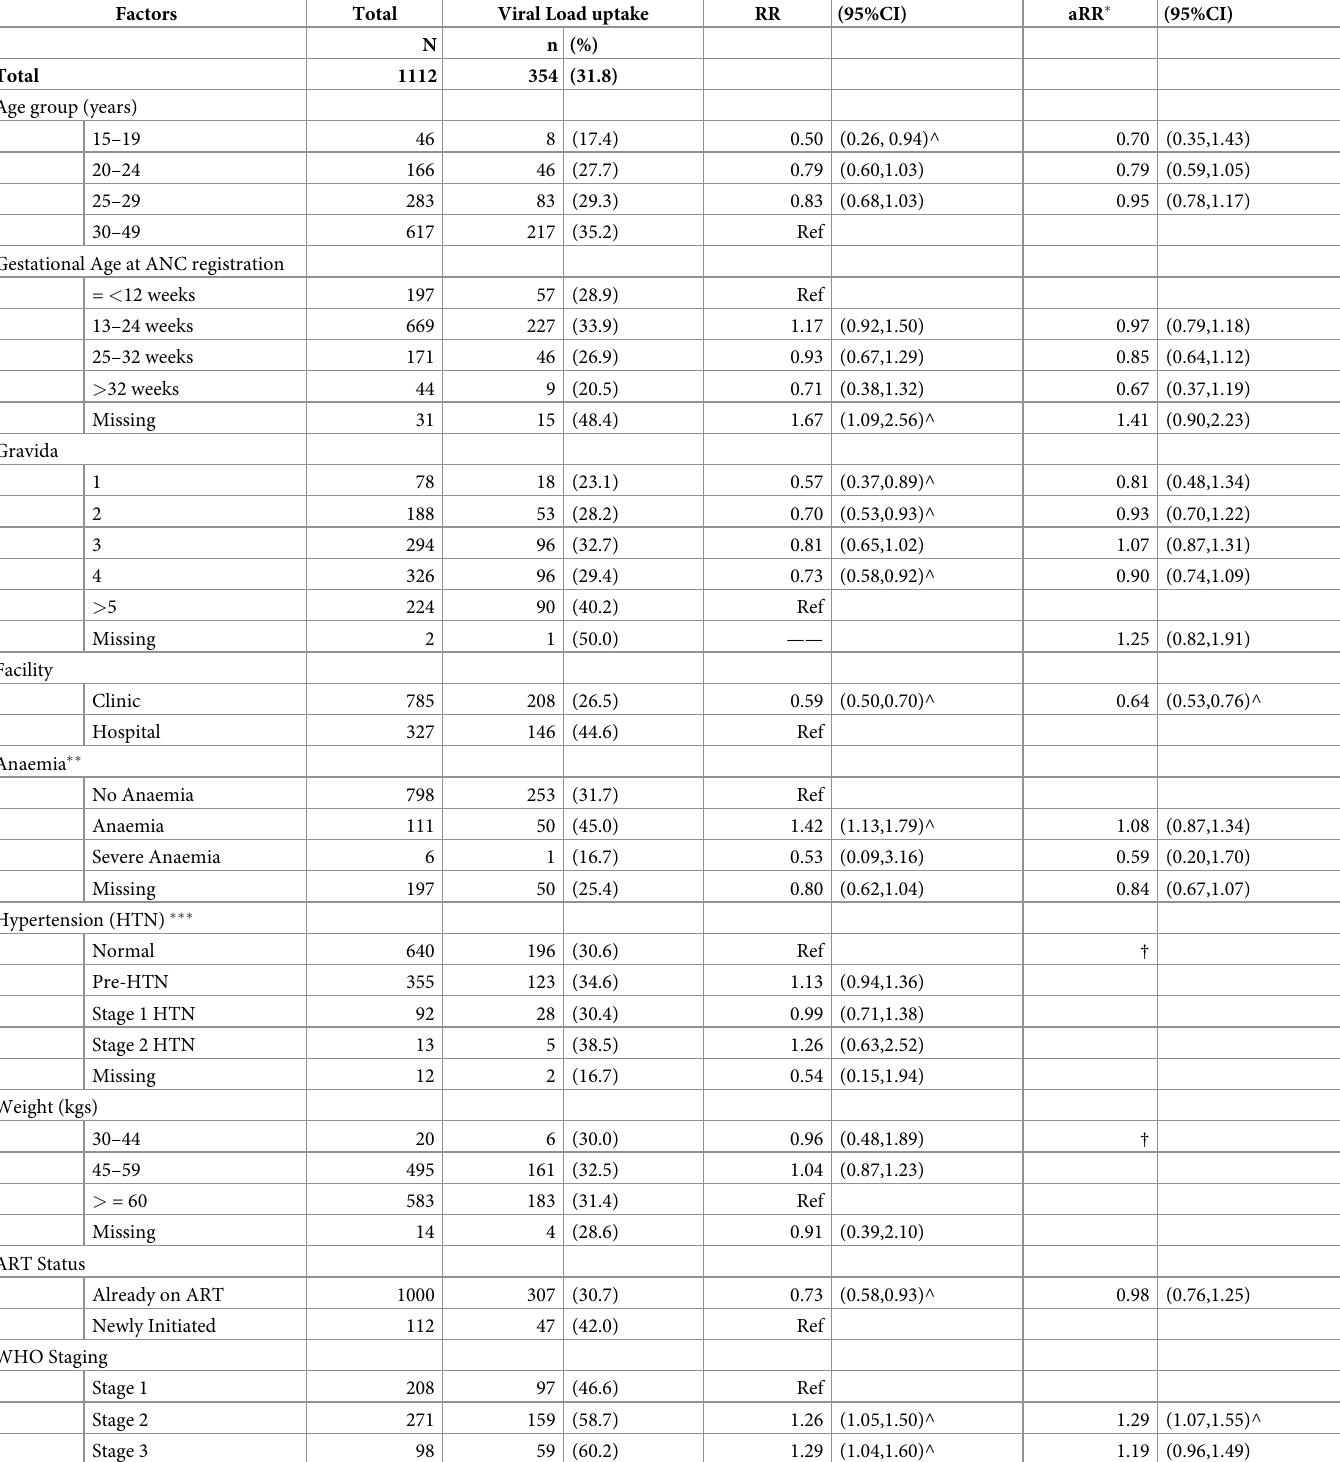
Table 2. Factors associated with uptake of VL test among the pregnancy cohort (living with HIV and on ART) registered for ante-natal care in Mazowe district, Zimbabwe